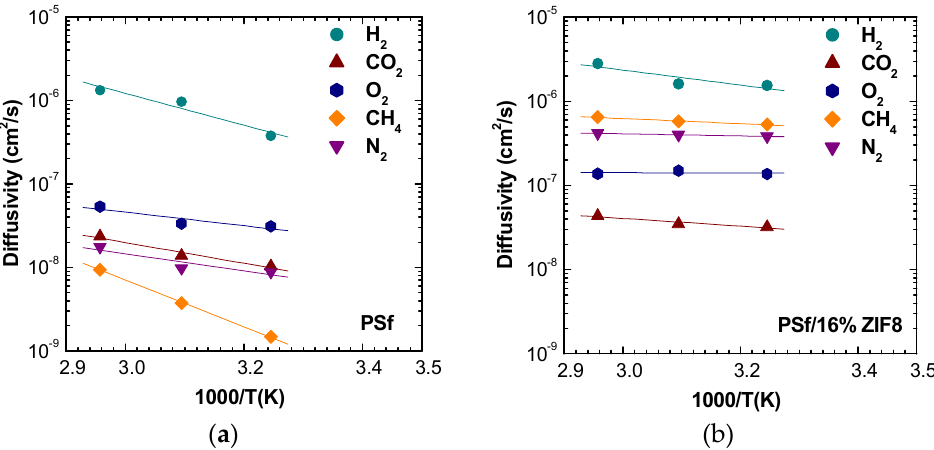
Figure 10. Diffusivity of various gases in PSf/ZIF-8 mixed matrix membranes as a function of 1000/T: ( a ) PSf; ( b ) PSf/16% ZIF-8. The behavior at intermediate loadings is reported in Figure S4.